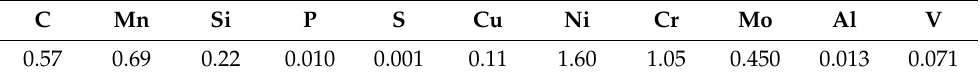
Table 4. Chemical composition of experimentally produced 55NiCrMoV7 tool steel/wt.%.